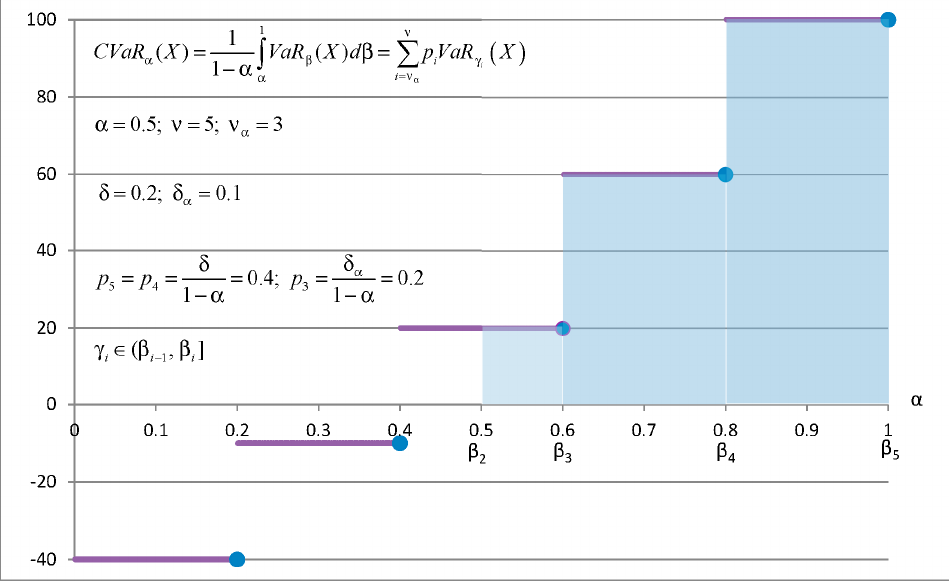
Figure 2. Five equally probable atoms. Risk in the CVaR quadrangle and mixed-quantile quadrangle with Set 1 of parameters for 𝛼 = 0.5.